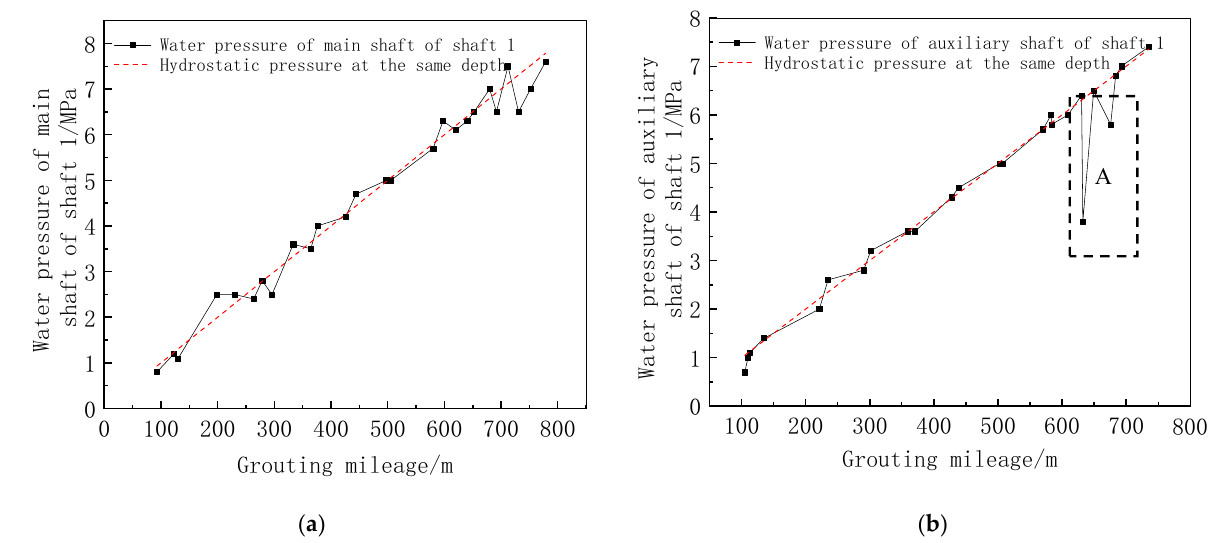
Figure 4. Measured water pressure of No. 1 and No. 2 shafts in Gaoligong Mountains. ( a ) Water pressure of main shaft of shaft 1; ( b ) Water pressure of auxiliary shaft of shaft 1.